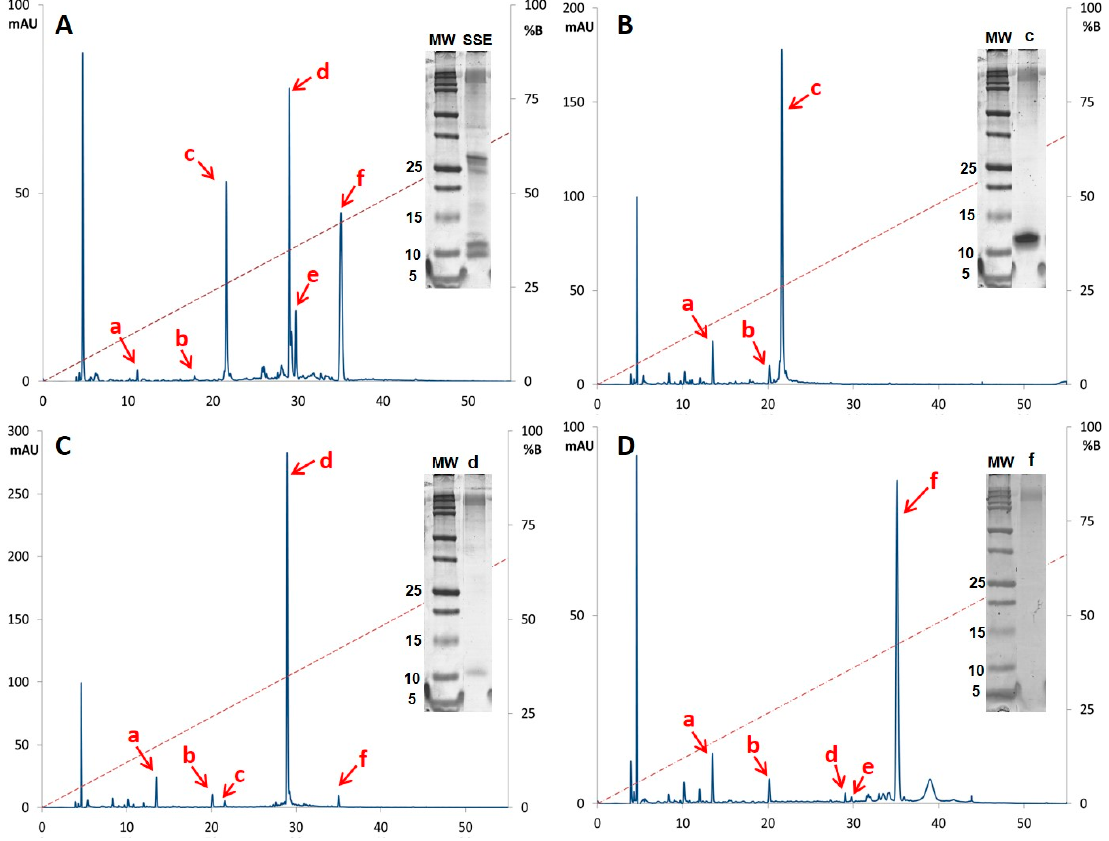
Figure 2. Analytical reverse-phase chromatograms and Tricine sodium dodecyl sulfate (SDS)-PAGE of the more abundant fractions recovered after SSE semi-preparative reversed-phase high-performance liquid chromatography (RP-HPLC) fractionation. ( A ) SSE with recovered fractions indicated by letters a, b, c, d, e and f. ( B ) Fraction c had a retention time of 22.3 min and an apparent molecular weight around 12 kDa. ( C ) Fraction d showed correlation with the 214 nm signal at 30.2 min and an apparent molecular weight around 11 kDa. ( D ) Fraction f showed 214 nm signal at 36.2 min, however it was not possible to correlate this fraction with any Tricine-PAGE band. Red dotted line represents the mobile phase composition for elution in relation to solvent B. M w : Molecular Weight marker; mAU: milli-Absorbance Units.